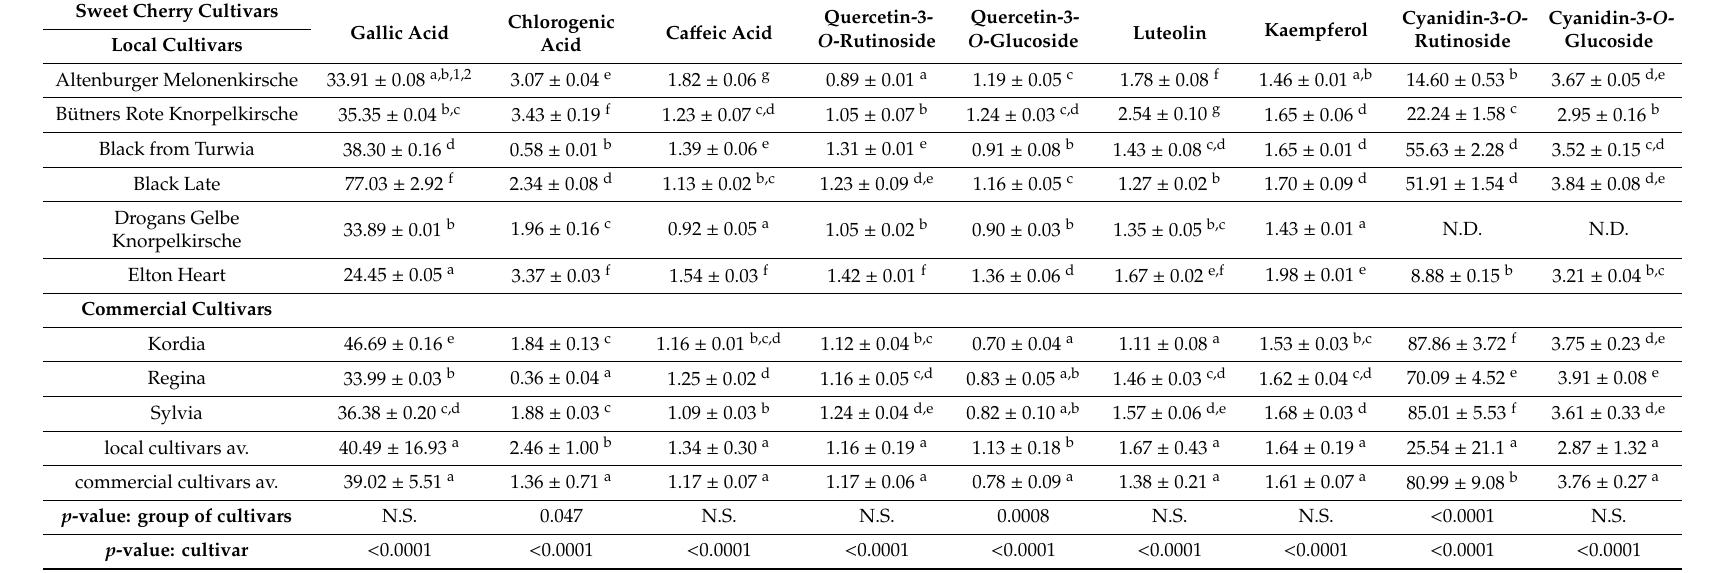
Table 3. The content of individual phenolic compounds (in mg 100 g − 1 FW) in sweet cherry fruit harvested in 2012. Sweet Cherry